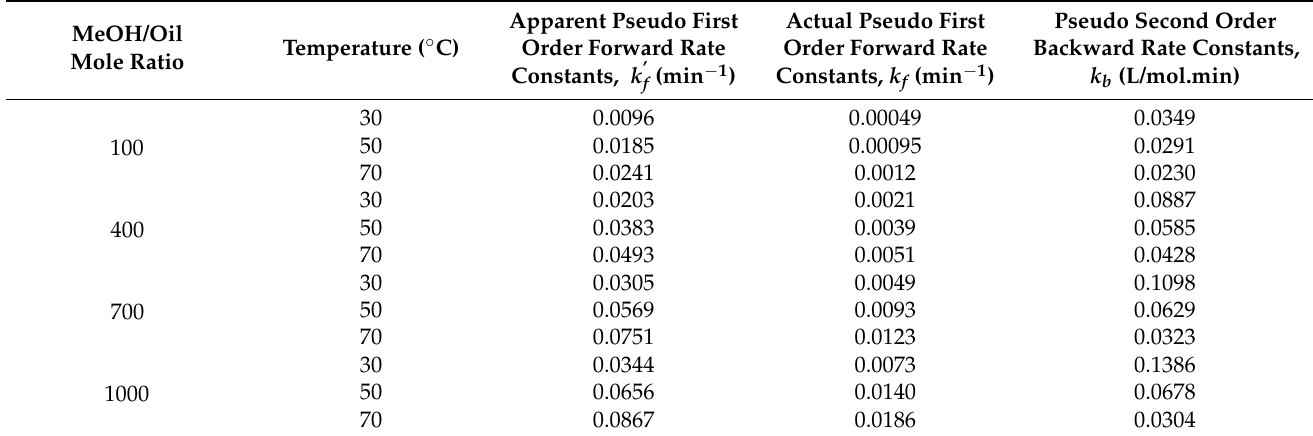
Table 3. Variation in rate constants with temperature and methanol/oil mole